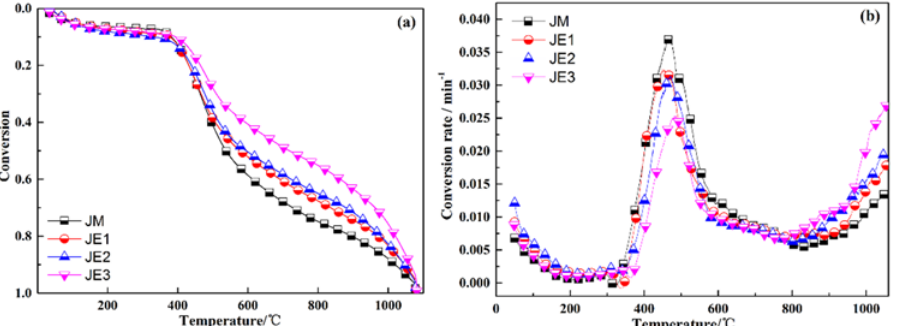
Figure 5. ( a ) Conversion and ( b ) conversion rate of the briquettes.